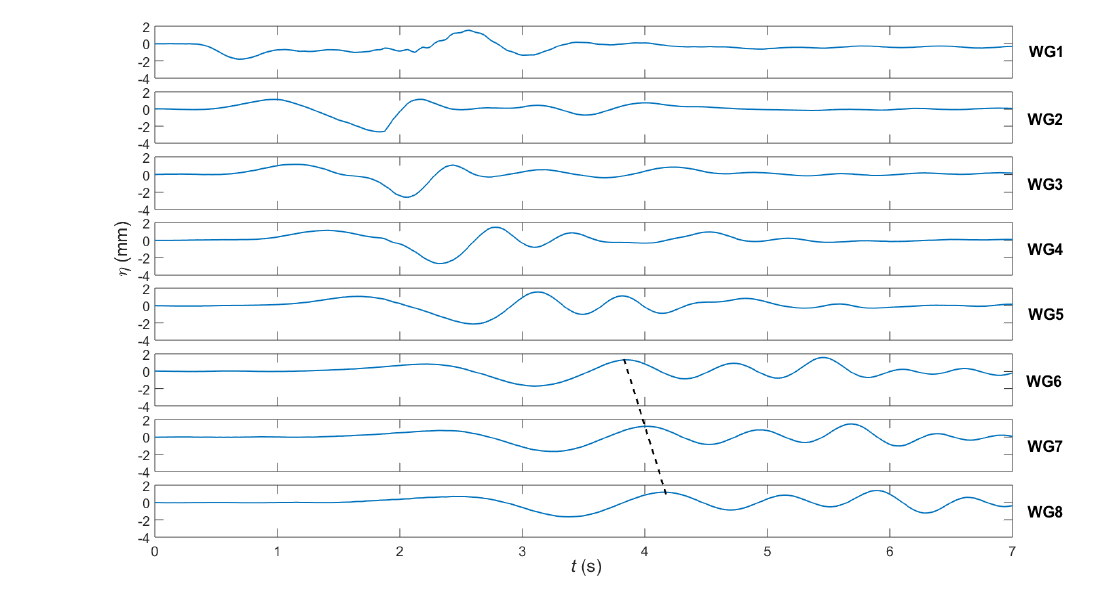
Figure 12. Surface elevation η time histories for an landslide only test in 370 mm water depth. The dashed line represents the constant wave celerity.